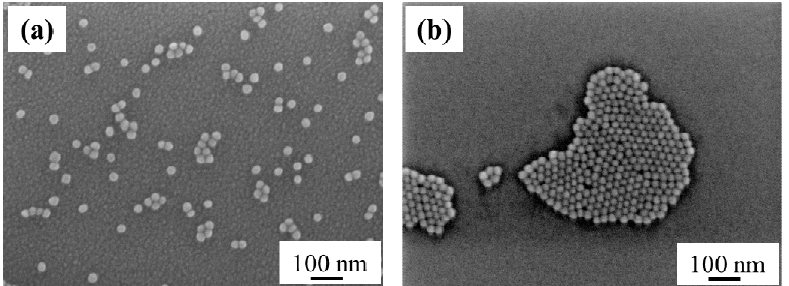
Figure 3 . Dispersity of the FeO nanoparticles on ( a ) an Al 2 O 3 /SiO 2 /Si substrate and ( b ) a SiO 2 /Si substrate.